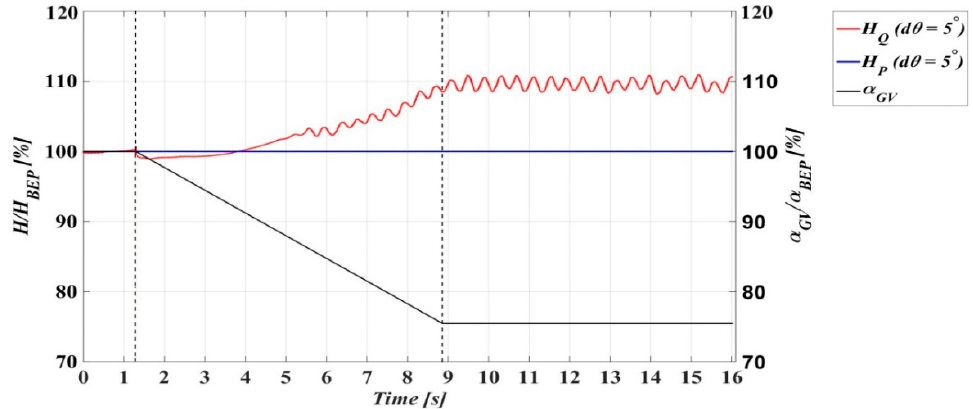
Figure 9. Time-dependent variation of the guide vane angle and head ( H ) during the load variation. The dotted vertical lines represent the start and the end of the guide vane closure.